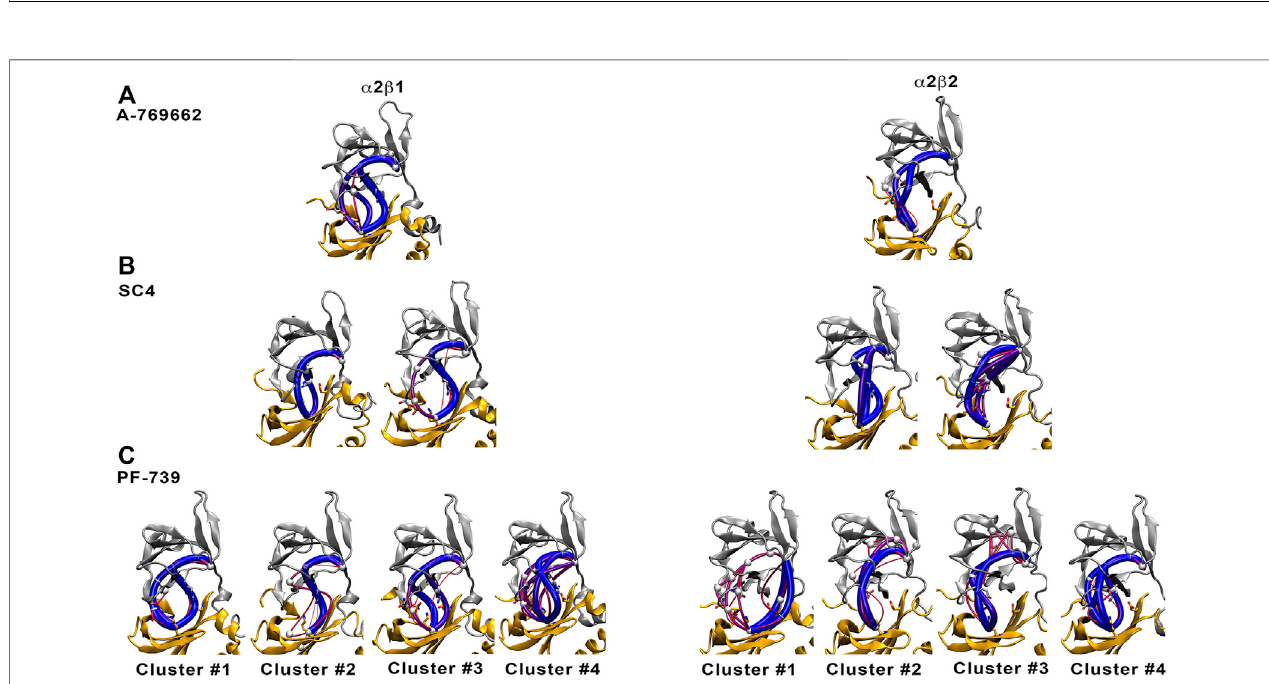
FIGURE10| ComparisonofmajorinteractionnetworksobtainedfromWISPanalysisfor α 2 β 1 (leftpanel) and α 2 β 2 (rightpanel) speciesoftheholostatesfor (A) A-769662, (B) SC4 and (C) PF-739 direct activators.